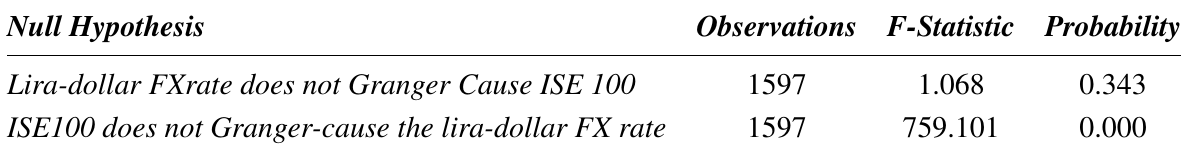
Table 2. Granger causality test results.